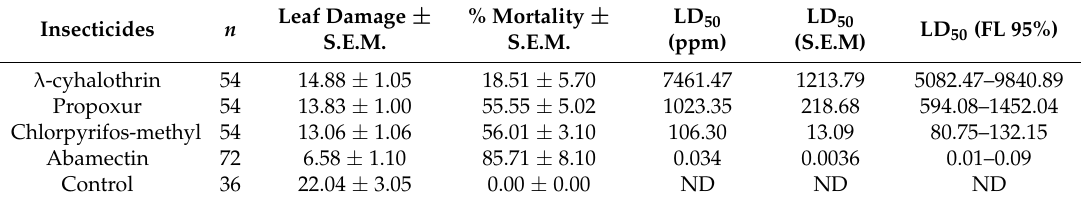
and LD 50s . ppm = part per million. ND = not